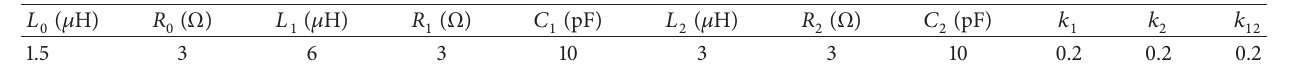
Table 5: Initial value of the antenna and two LC circuits.